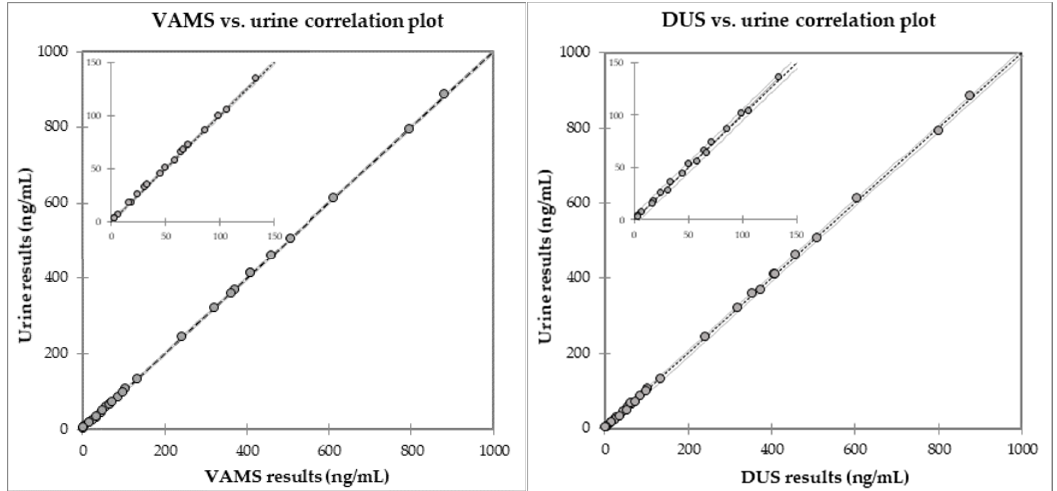
Figure 4. Statistical correlation plots for VAMS vs. urine and DUS vs. urine result